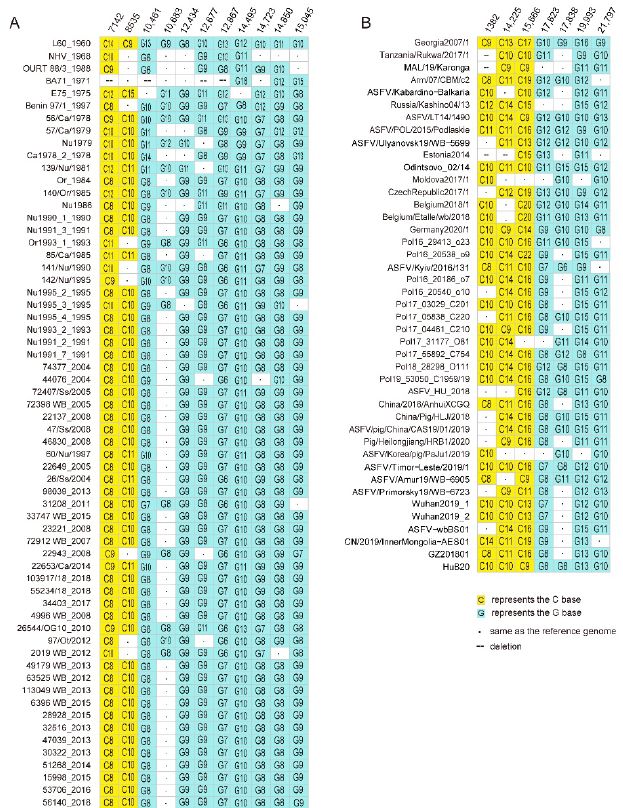
Figure 6. Sequence variation of the highly variable poly G or poly C repeats sequence in ASFV genotype I ( A ) and genotype II ( B ) genomes. Nucleotide position in the reference genome L60 ( A ) and genome Georgia 2007/1 ( B ) is shown.